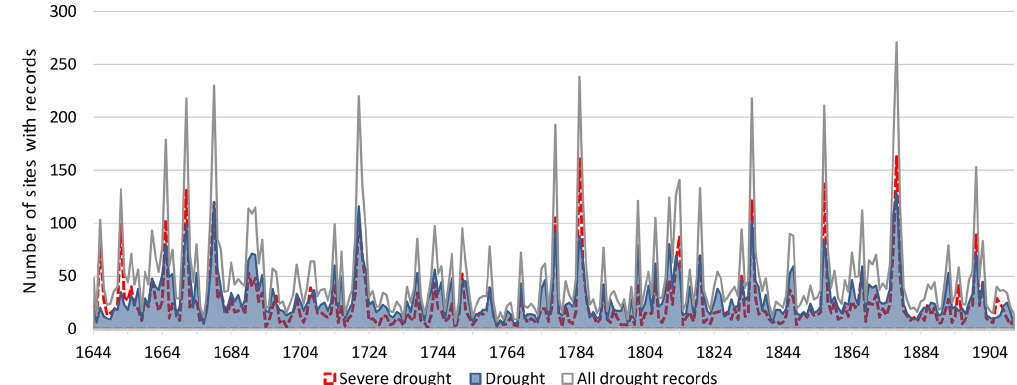
Figure 3. Time series plot of annual normal drought, severe drought, and all drought populations in REACHES during the Qing